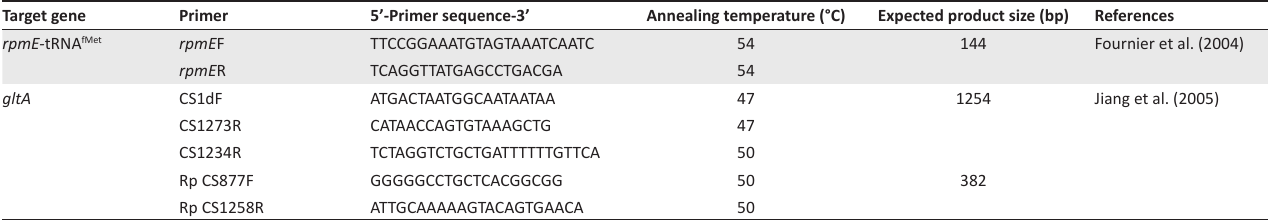
TABLE 1: Primers used for polymerase chain reaction amplification and sequencing of spotted fever group rickettsiae in wildlife. Target